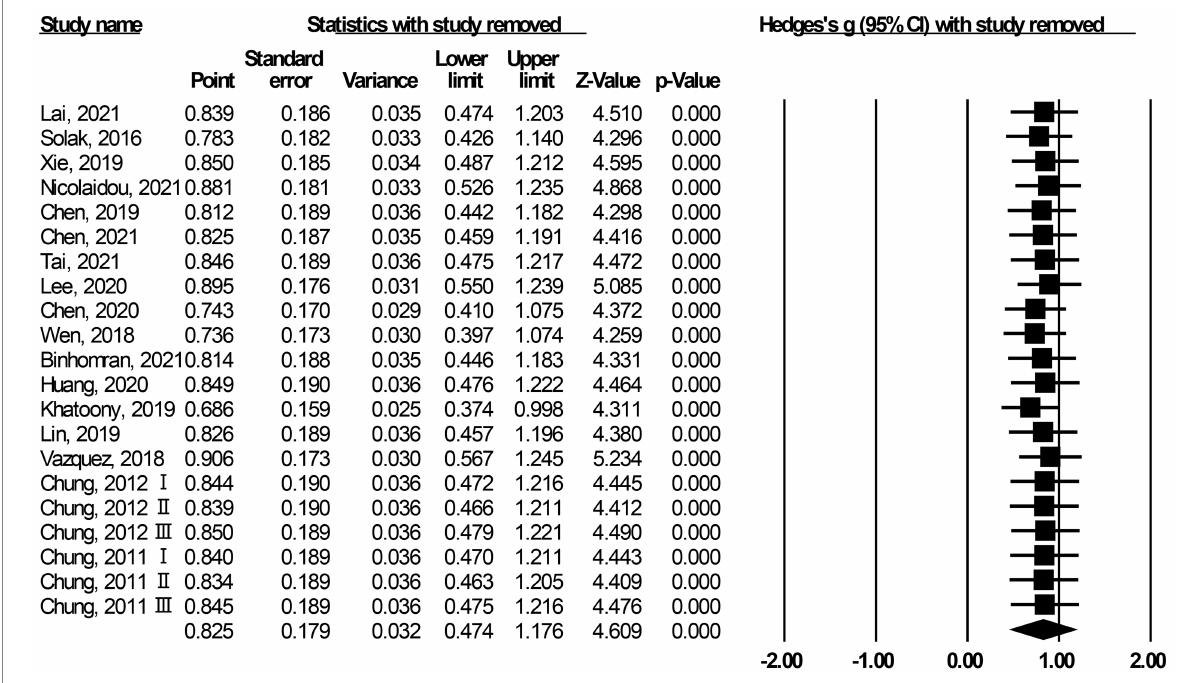
FIGURE 3 Results of the sensitivity analysis.